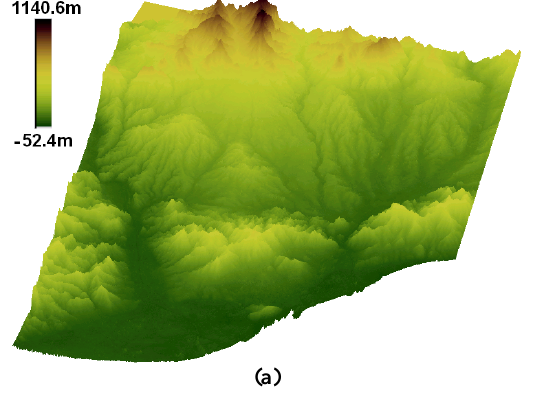
Table 2. Accuracy results of TSX